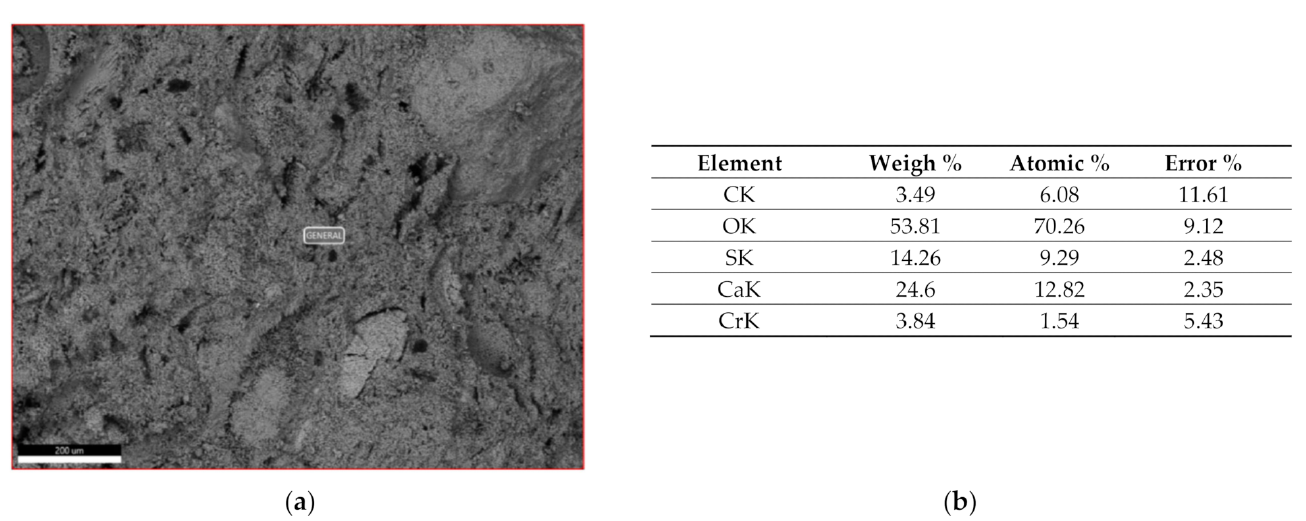
Figure 18. Analysis area and composition results (source: the author): ( a ) micrograph of calcium sulfate without additive; ( b ) chemical composition of the reference gypsum.